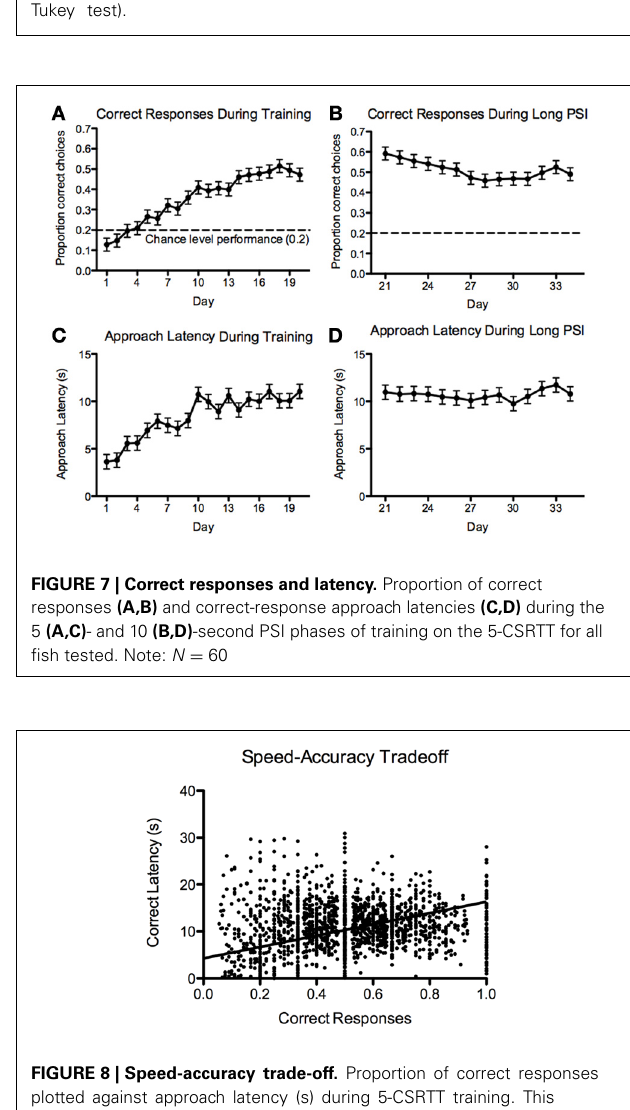
a decrease in the number of reinforcers delivered during magazine training on day 2 (A) but no other differences during this phase.